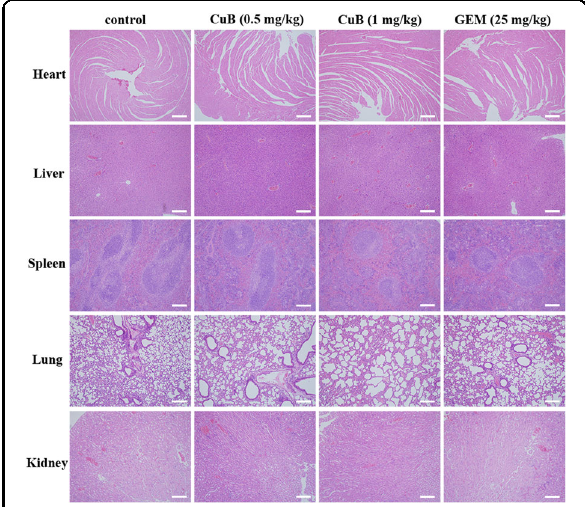
Fig. 8 The representative images of H&E staining of heart, liver, spleen, lung, and kidney from mice in each group at the end of the observation period. Scale bars: 100 μ m.